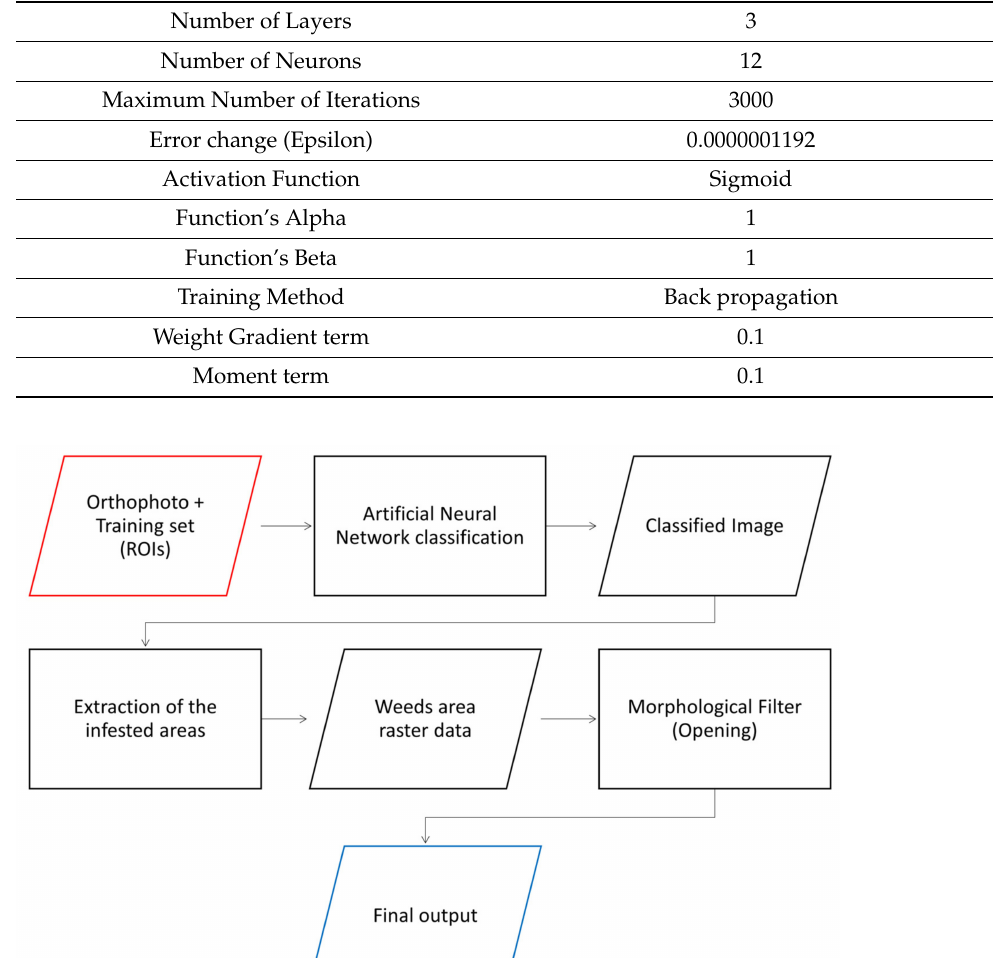
Table 1. Artificial Neural Network parameters settings.